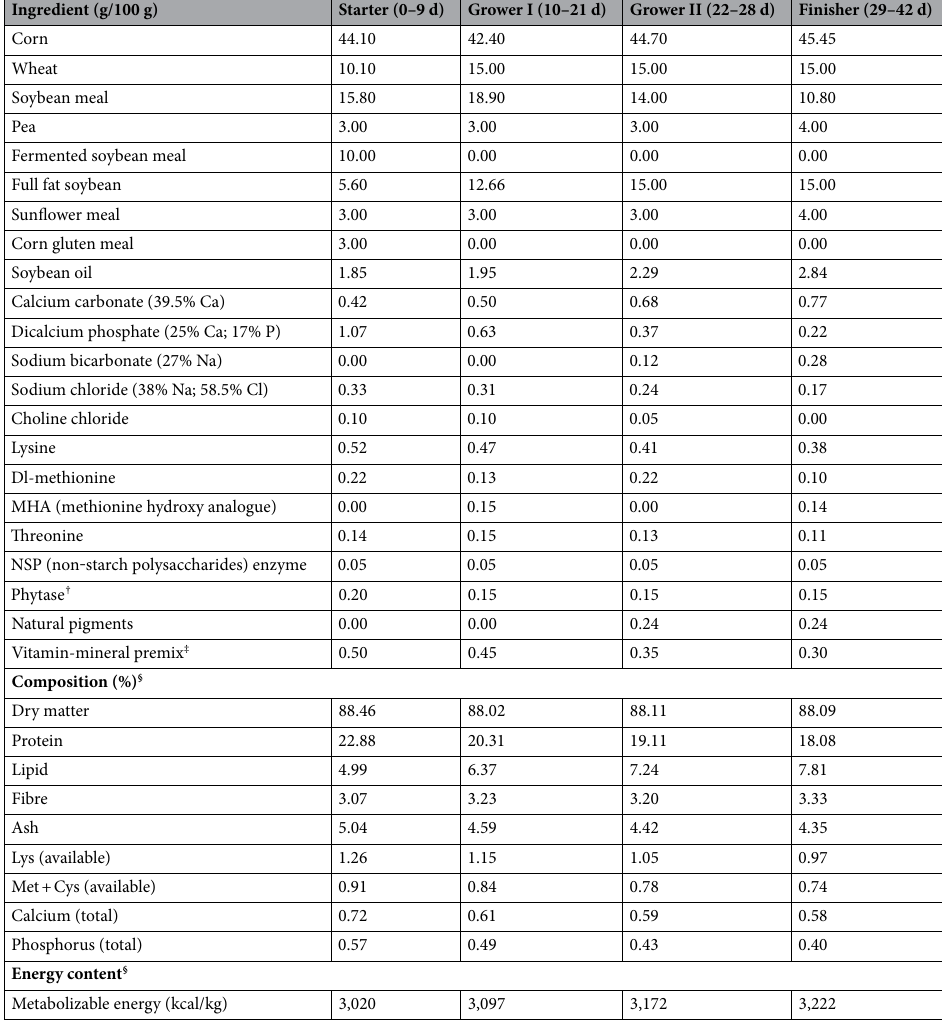
Table 6. Basal diet composition according to feeding phases. † The premix included at 0.1% provides 1,000 FTU per kg of feed. ‡ The premix provides the following per kg of feed: vitamin A (retinyl acetate), 13,000 IU; vitamin D3 (cholecalciferol), 4,000 IU; vitamin E (DL-α_tocopheryl acetate), 80 IU; vitamin K (menadione sodium bisulfite), 3 mg; riboflavin, 6.0 mg; pantothenic acid, 6.0 mg; niacin, 20 mg; pyridoxine, 2 mg; folic acid, 0.5 mg; biotin, 0.10 mg; thiamine, 2.5 mg; vitamin B 12 20 μg; Mn, 100 mg; Zn, 85 mg; Fe, 30 mg; Cu, 10 mg; I, 1.5 mg; Se, 0.2 mg; ethoxyquin, 100 mg. § Calculated